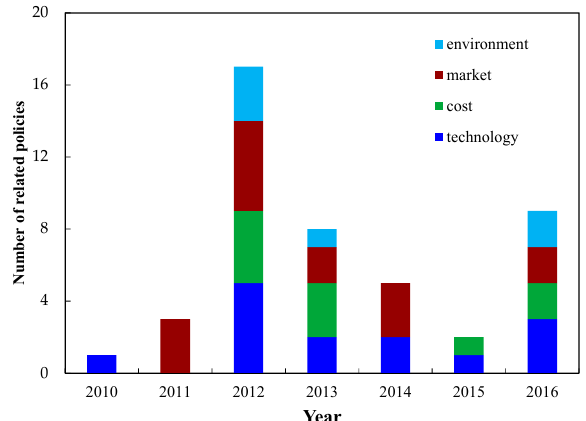
Figure 2. Technology and market issues are always the focus of policymakers between 2010 and 2016, while the environmental issue gets little concern.